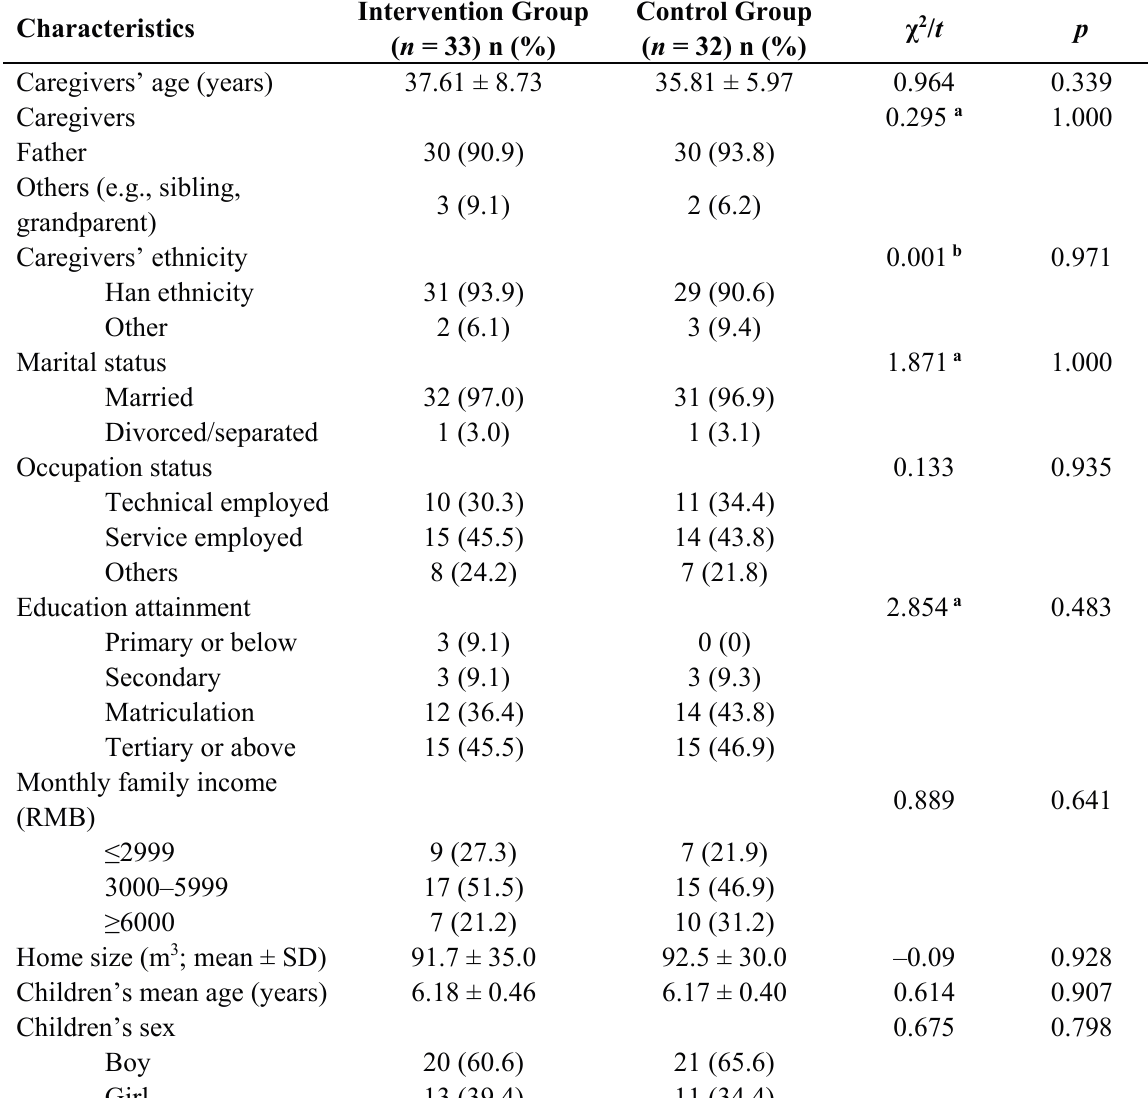
Table 1. The characteristics of study participants at the